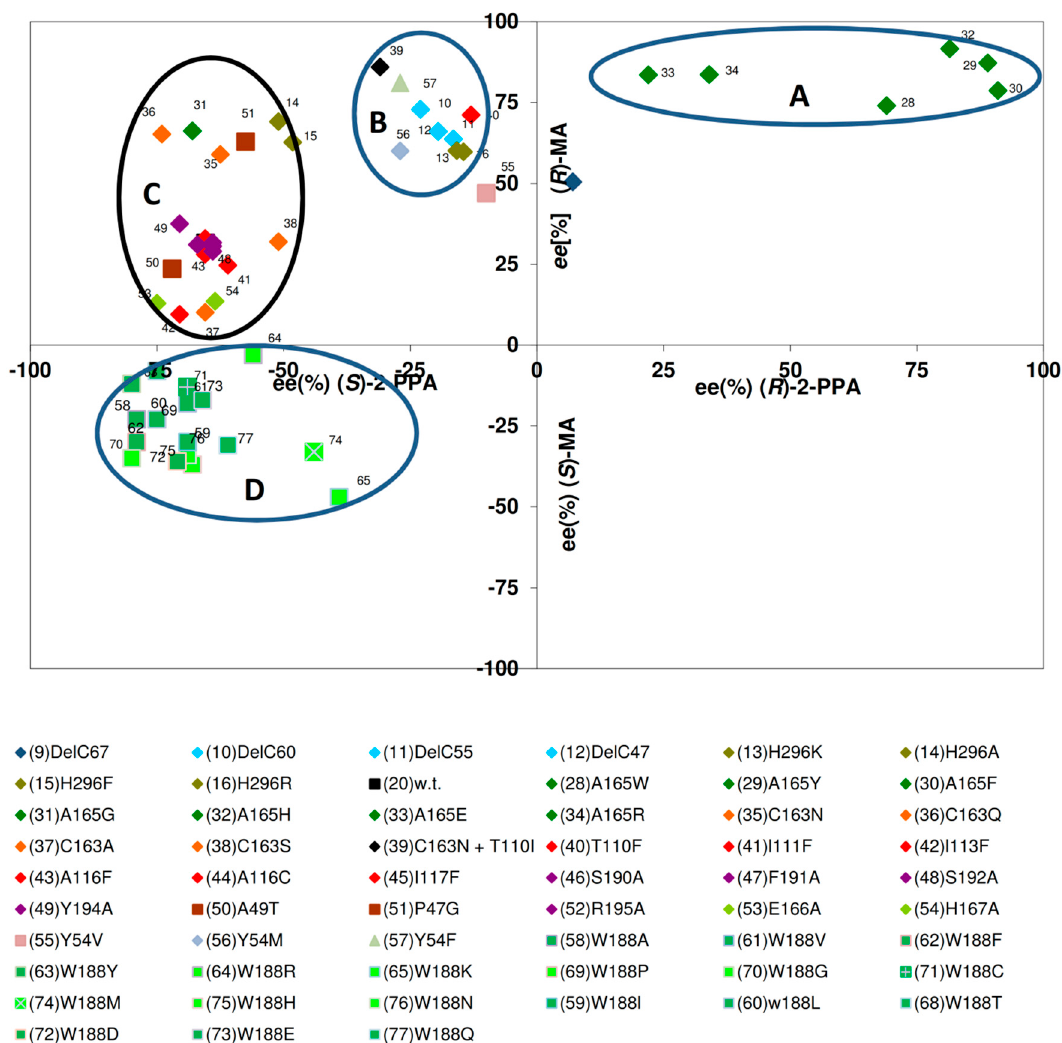
Figure 6. Correlation of the enantiomeric composition of the acids formed from ( R,S )-mandelonitrile and ( R,S )-2-phenylpropionitrile by different nitrilase variants. The indicated values were obtained from the experimental data presented in the articles of Kiziak et al. (2007) [39], Kiziak and Stolz (2009) [46], Sosedov et al. (2010) [47], Baum et al. (2012) [45], Sosedov and Stolz (2015) [23], and includes also some unpublished results. The respective reaction mixtures contained initially 10 mM of ( R,S )-mandelonitrile or ( R,S )-2-PPN. The ee-values were determined after about 30% substrate turn-over.